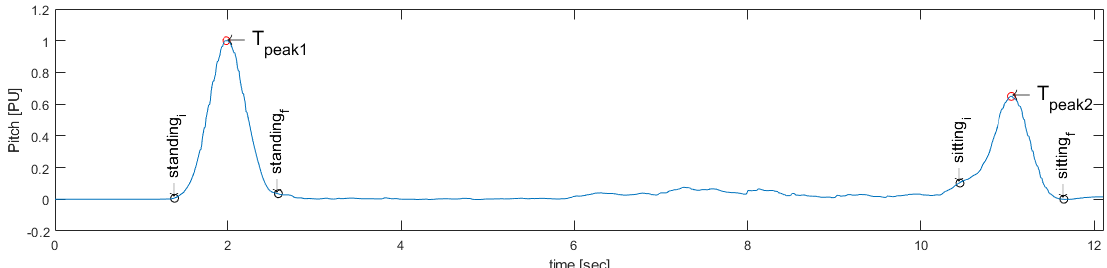
Figure 6. Result of the proposed method for the search of the beginning ( standing i ) and the end ( standing f ) of the Standing event and for the search of the beginning ( sitting i ) and the end ( sitting f ) of the Sitting event.